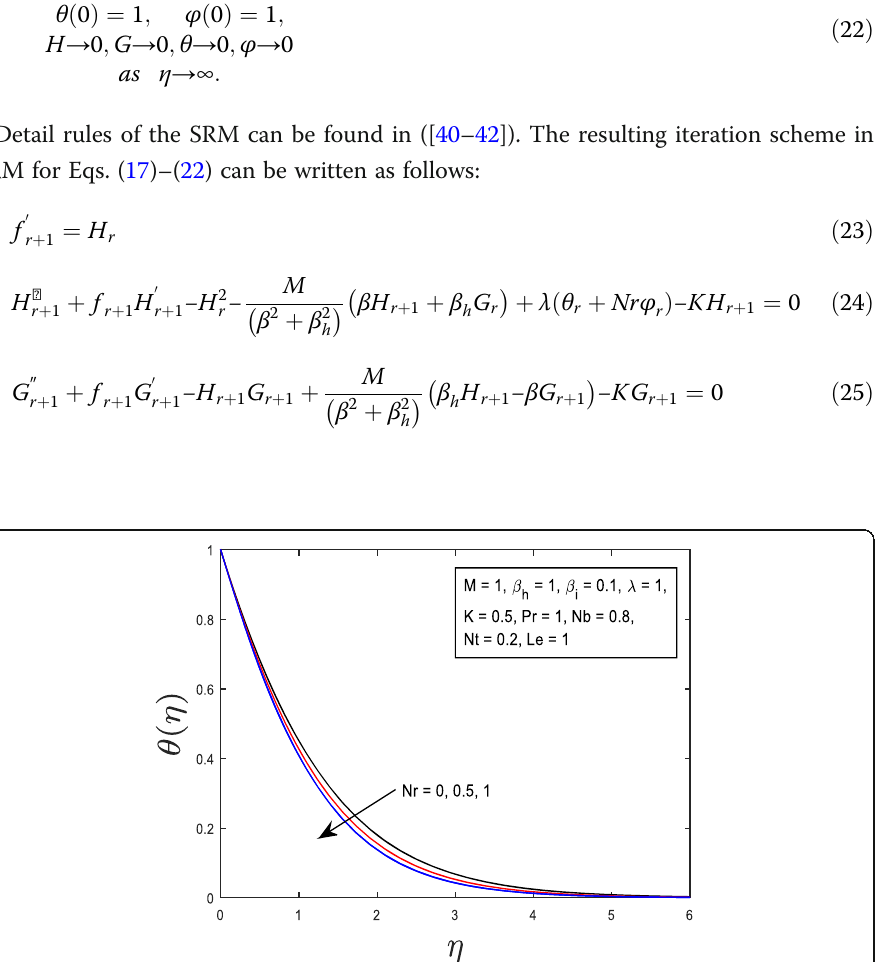
Fig. 16 Graph of temperature for various values of